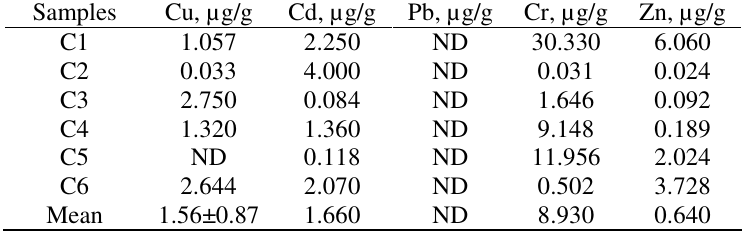
Table 1. Concentration of heavy metal in six different samples of crab.